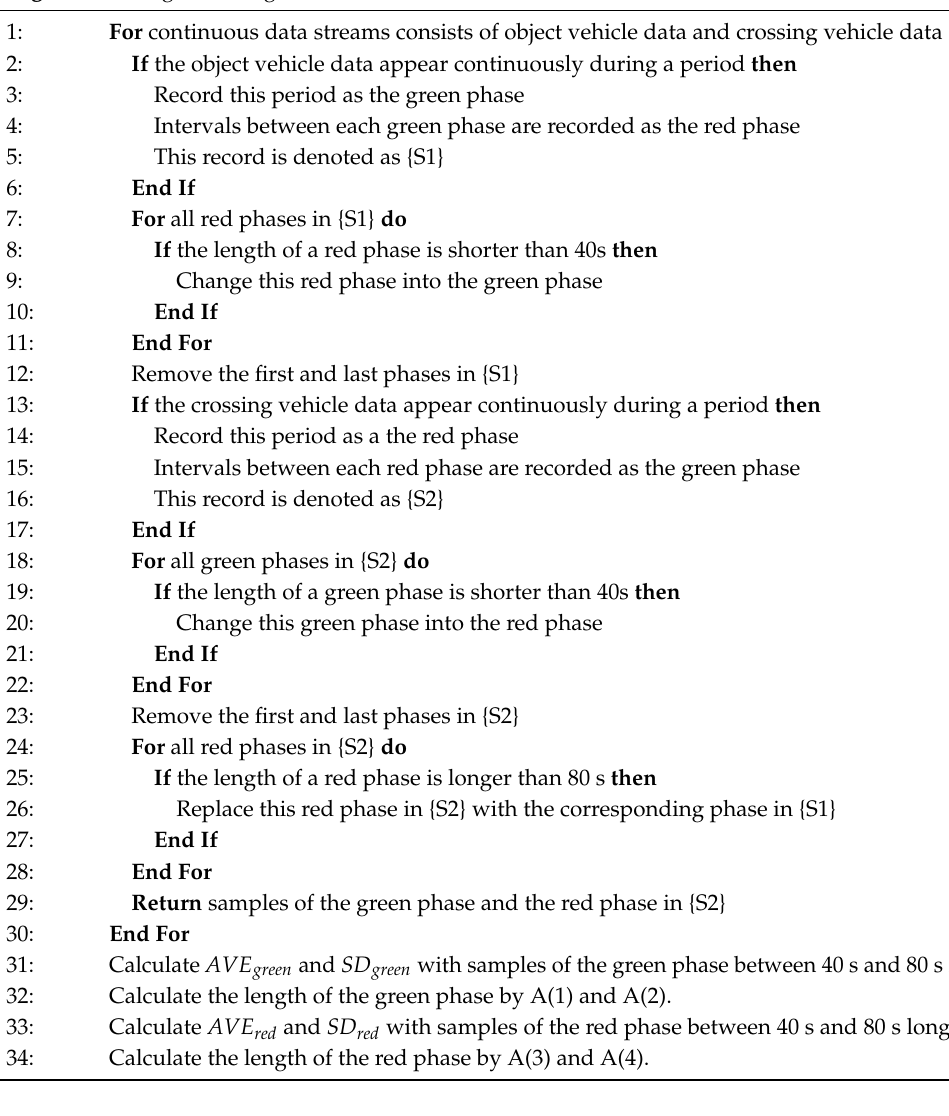
Algorithm 3 : Signal timing